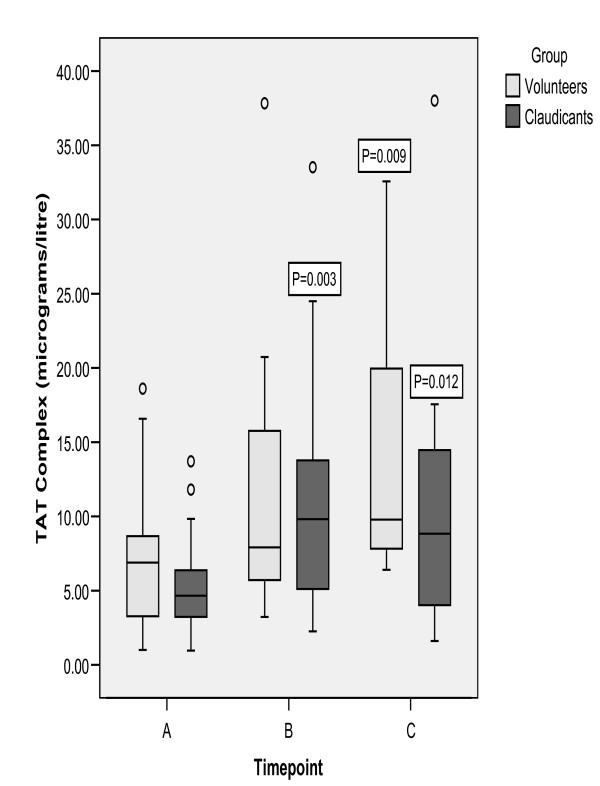
Plasma TAT complex following treadmill exercise. Healthy volunteers are represented by the grey boxes, and patients with intermittent claudication by the black boxes. A = baseline; B = immediately post-exercise; C = 1 hour post-exercise. Data presented as box-plots- line in centre of box represents the median value; the box represents the inter-quartile range and the whiskers represent the range. Markers out with the whiskers are outliers i.e. cases with values between 1.5 and 3 box lengths from the upper or lower edge of the box. P- values are Wilcoxon signed-rank test compared to baseline. Friedman test: P < 0.05